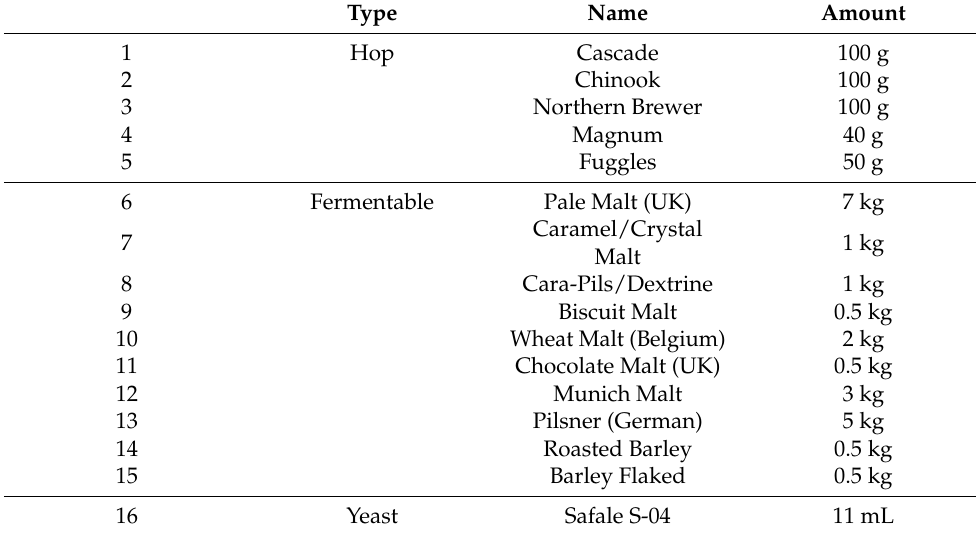
Table 1. Real-world list of in-stock inventory.